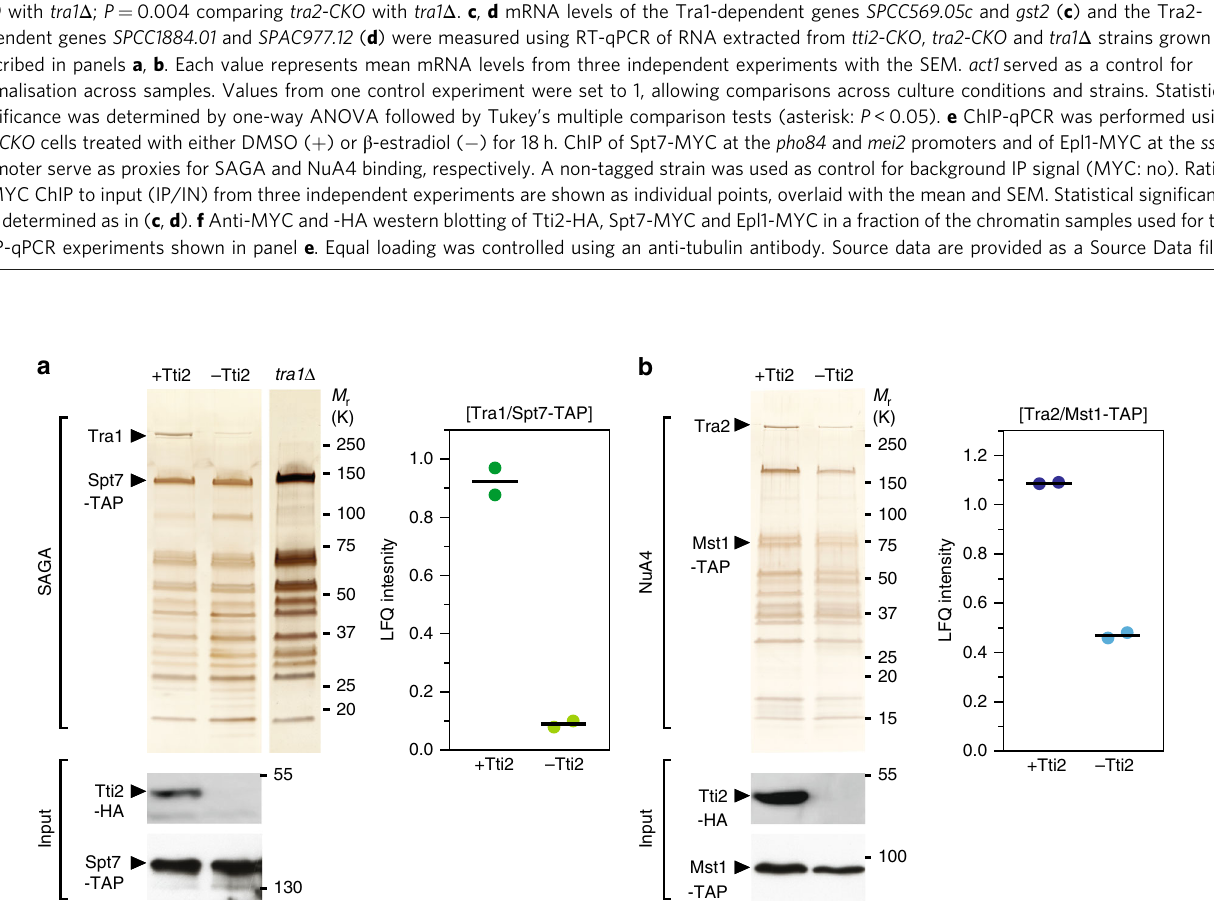
Fig. 1 The TTT subunit Tti2 contributes to Tra1- and Tra2-dependent gene expression. a , b RNA-seq analyses of control creER , inducible tti2 ( tti2-CKO ) and tra2 knockouts ( tra2-CKO ), tra1 Δ and wild-type (WT) strains ( n = 3 independent biological samples). creER , tti2-CKO and tra2-CKO cultures were supplemented with either DMSO ( + Tti2 or + Tra2) or β -estradiol (-Tti2 or -Tra2), for either 21 h ( creER and tra2-CKO ) or 18 h ( tti2-CKO ). a Density scatter plots comparing Tti2- with Tra2-depleted cells (left, r = 0.46, P < 0.001), Tti2-depleted cells with Tra1 deletion mutants (middle, r = 0.36, P < 0.001), and Tra2-depleted cells with Tra1 deletion mutants (right, r = − 0.07, P < 0.001). Statistical signi fi cance and correlation were analysed by computing the Pearson correlation coef fi cient. Differential gene expression analyses were performed comparing cells treated with either DMSO (control) or β -estradiol (KO), while tra1 Δ mutants were compared with isogenic WT cells. Genes whose expression is regulated by β -estradiol treatment (Supplementary Fig. 3a) were fi ltered out. b Venn diagrams showing the overlap of differentially expressed genes (DEGs) between all mutants. Using FC ≥ 1.5, P ≤ 0.01 thresholds, 184 DEGs were identi fi ed in Tti2-depleted cells, 153 in Tra2-depleted cells and 59 in tra1 Δ mutants. Statistical signi fi cance was calculated using a hypergeometric test: P = 8.66e-115 comparing tti2-CKO , tra2-CKO and tra1 Δ ; P = 3.67e-72 comparing tti2-CKO with tra2-CKO ; P = 2.37e-15 comparing tti2- CKO with tra1 Δ ; P = 0.004 comparing tra2-CKO with tra1 Δ . c , d mRNA levels of the Tra1-dependent genes SPCC569.05c and gst2 ( c ) and the Tra2- dependent genes SPCC1884.01 and SPAC977.12 ( d ) were measured using RT-qPCR of RNA extracted from tti2-CKO , tra2-CKO and tra1 Δ strains grown as described in panels a , b . Each value represents mean mRNA levels from three independent experiments with the SEM. act1 served as a control for normalisation across samples. Values from one control experiment were set to 1, allowing comparisons across culture conditions and strains. Statistical